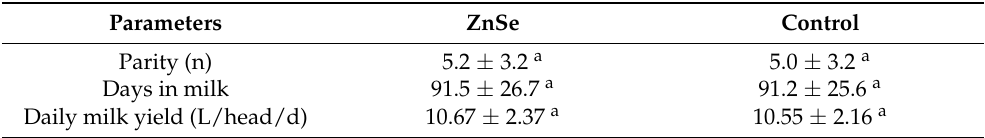
Table 1. Characteristics of the two groups at the beginning of the experiment. Data are expressed as means ± SD. a Same letters indicate no significant